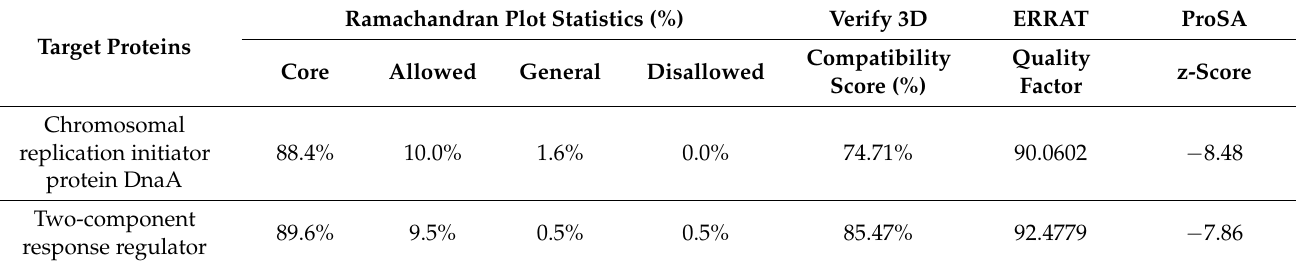
Compatibility Quality Score (%)